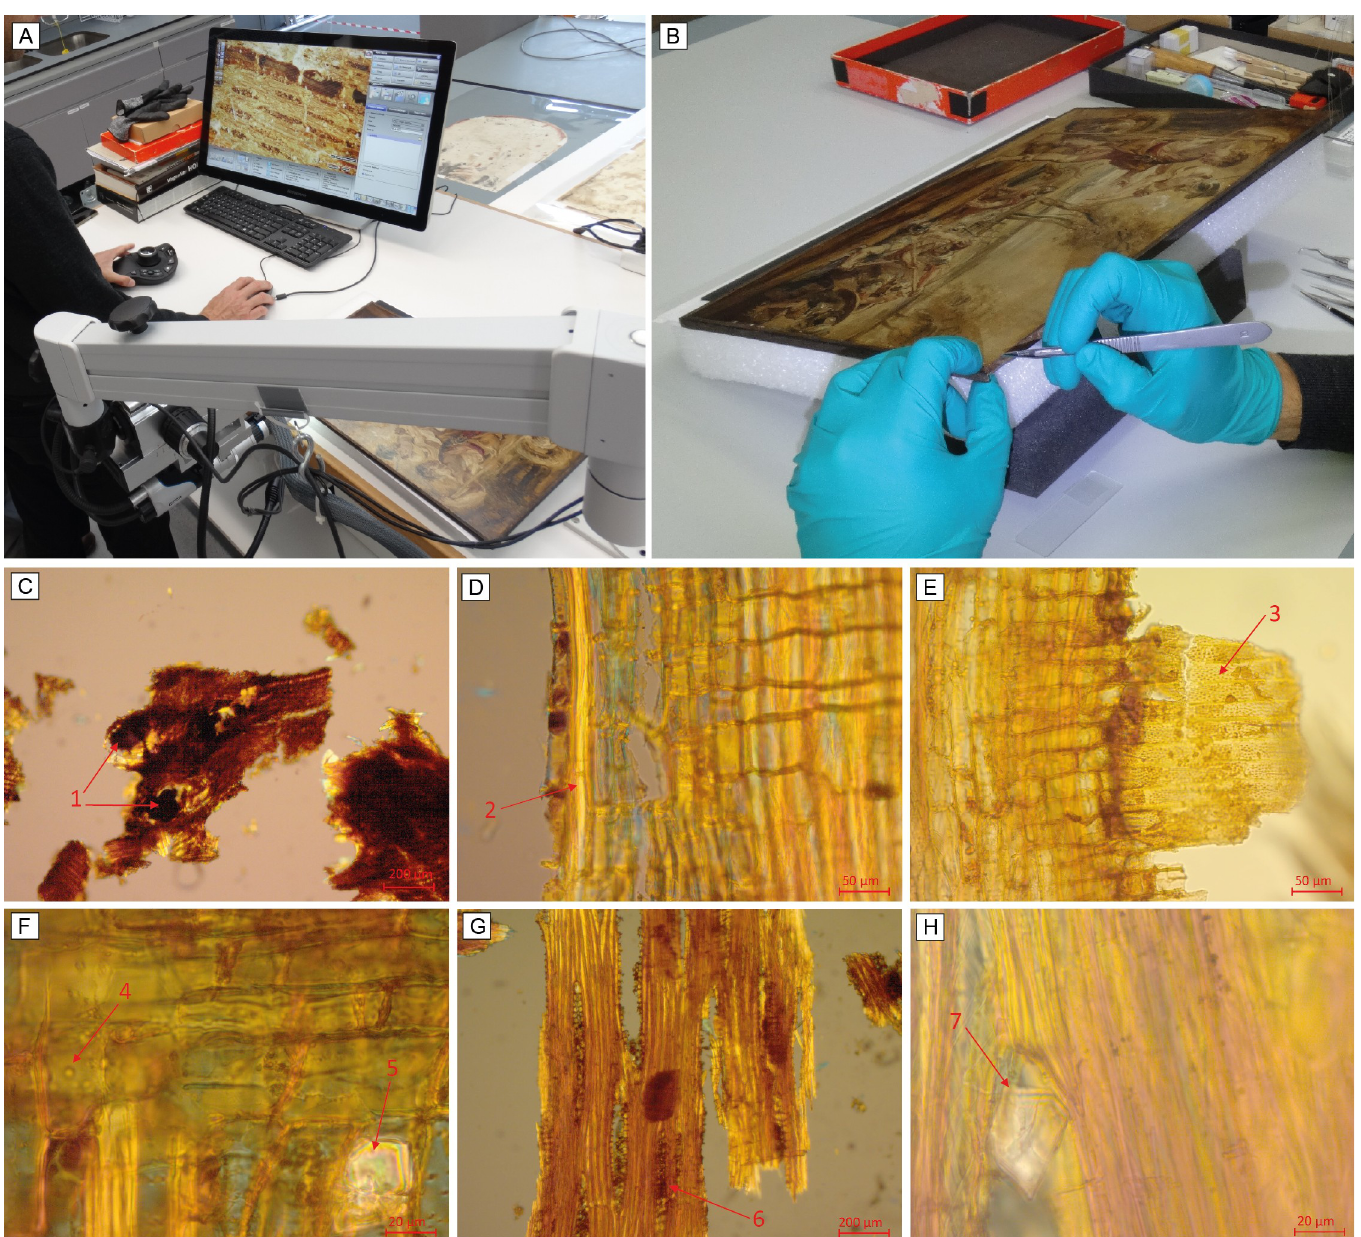
Fig 5. Species identification of the front (original) support. (A) direct observation of wood anatomical features with the Hirox RH-2000 digital microscope; (B) removal of a micro sample of wood from the original support in the top-right corner for wood identification. Key anatomical features characteristic for Swietenia sp. [52–54]: (C) Transverse section, 50x: large vessels 100–270 μ m, diffuse-porous, mostly solitary, occasionally in pairs; gums in vessels (1); parenchyma apotracheal and paratracheal; terminal parenchyma are not visible due to small sample size. (D) Radial section, 200x: septate fibres (2) present; gums in parenchyma. (E) Radial section, 200x: Simple perforation plates; numerous vessel ray pits (3) alternate, simple, very small 1.9 to 3.5 μ m. (F) Radial section, 500x: cross-field pits small and bordered (4), prismatic crystals in marginal (procumbent) ray cells (5). (G) Tangential section, 200x: Rays 1–4 cells wide (6), 9–20 cells high, slightly heterogeneous, slightly storied. (F) Tangential section, 500x: prismatic crystals in marginal (procumbent) ray cells